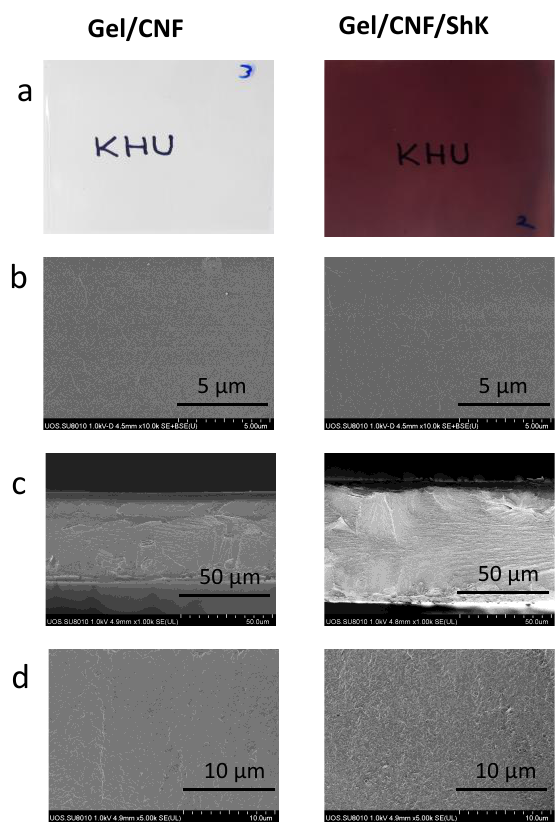
Figure 3. Apparent image and morphology of the smart films. ( a ) apparent image, ( b ) surface SEM image, ( c , d ) cross-sectional SEM images.